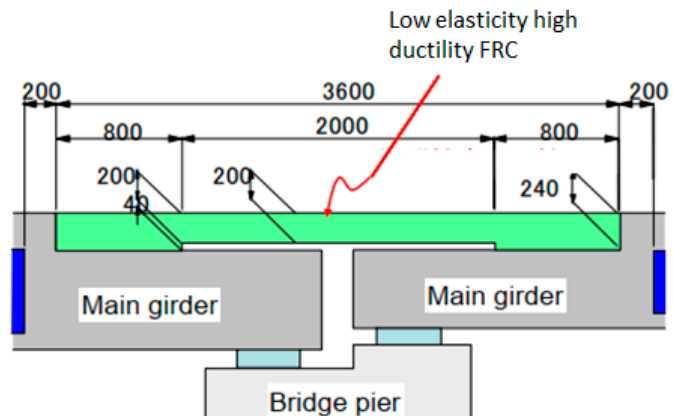
Figure 10. Schematic of a bridge deck connecting slab (adapted from [160] ).